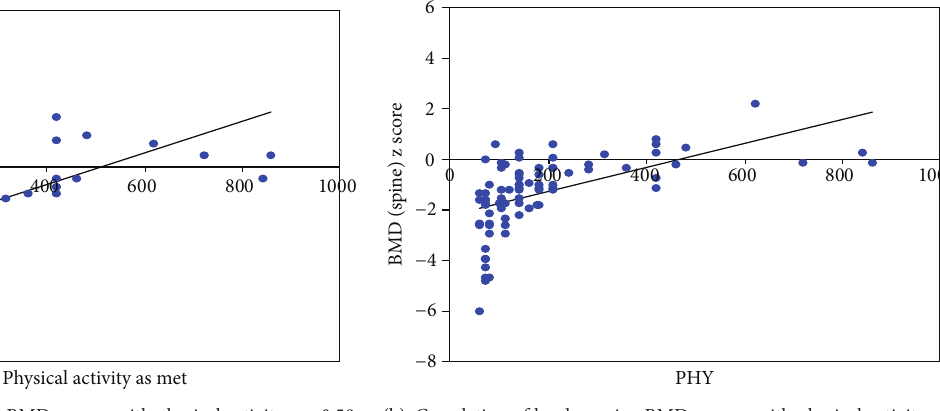
(a) Correlation of total body BMD 𝑧 score with physical activity 𝑟 = 0.58 ; 𝑃 < 0.05